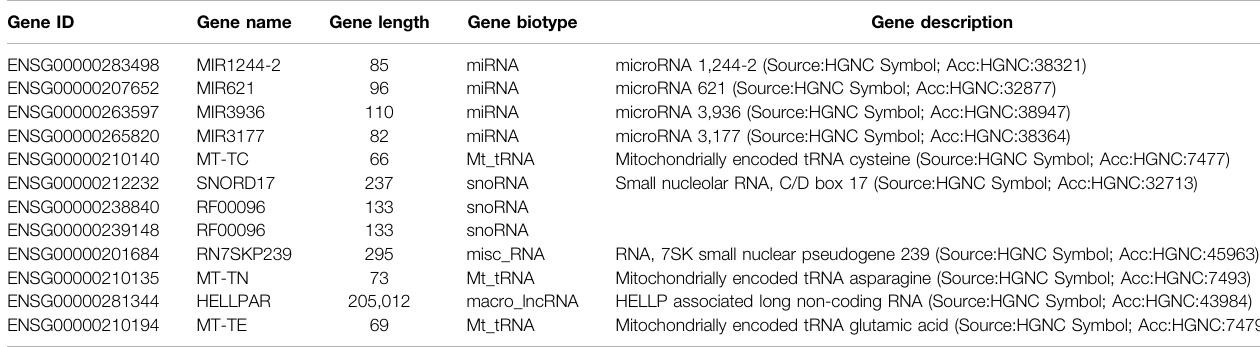
TABLE 1 | All microRNA changed in HuR Knockdown A549 cell by RNA Sequencing analysis. Gene ID Gene name Gene length Gene biotype Gene